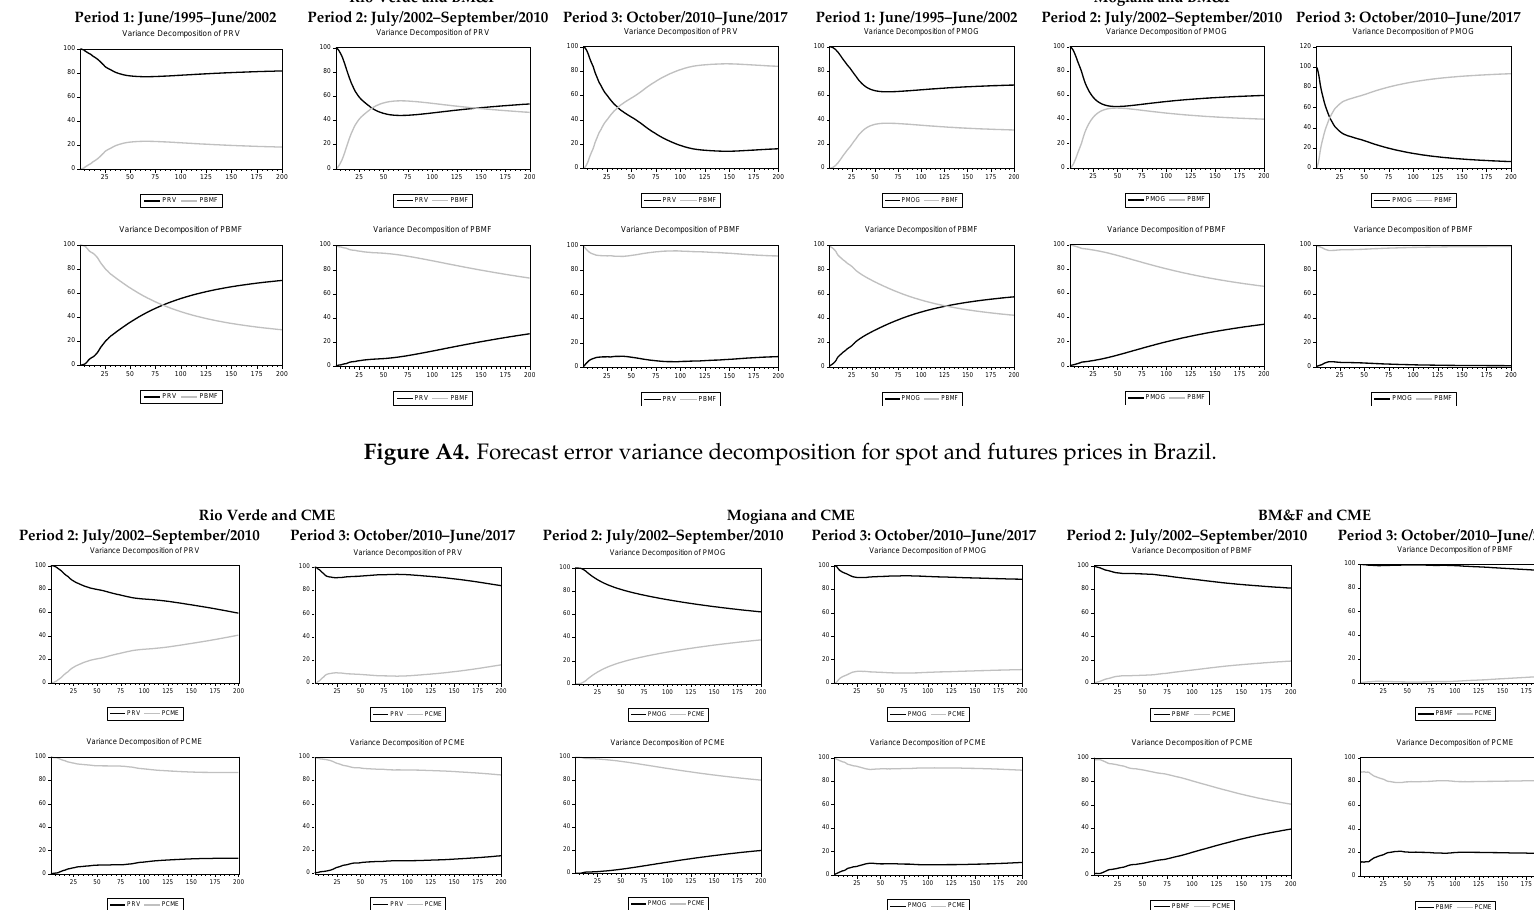
Figure A5. Forecast error variance decomposition for spot prices in Brazil and futures prices in the U.S., and futures prices in Brazil and U.S. in in 2002–2010 and 2010–2017.